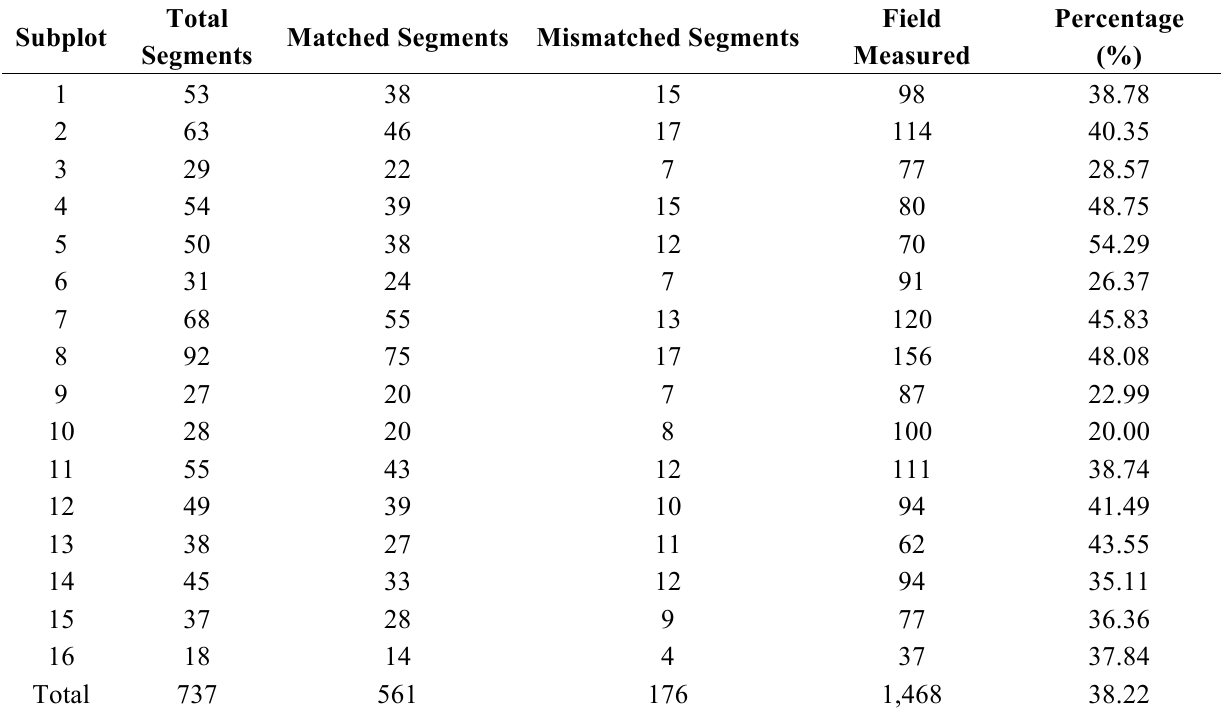
Table 2. Statistics of watershed segmentation results for the 16 subplots in a super-plot. Subplot